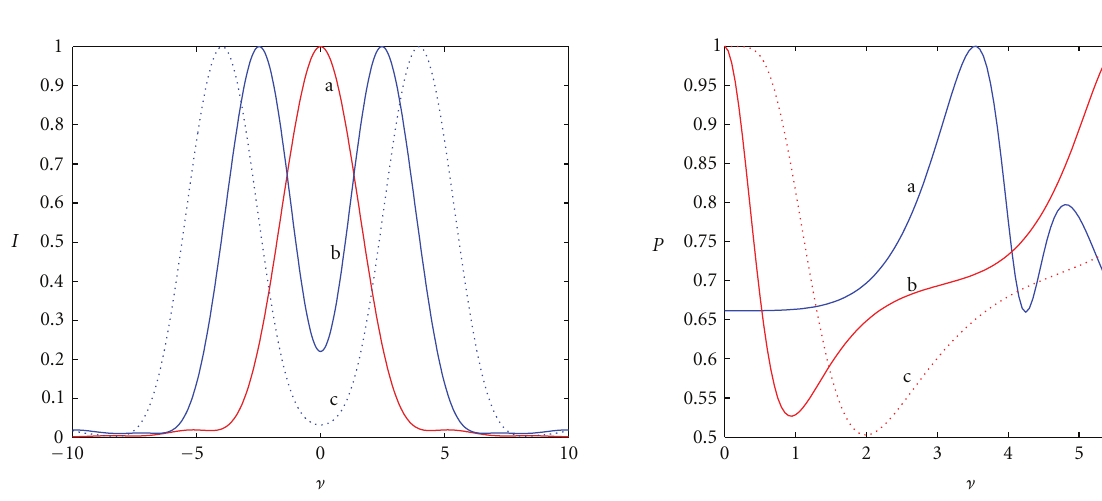
. 5 (h) μ . 8. o = 0 o = 0